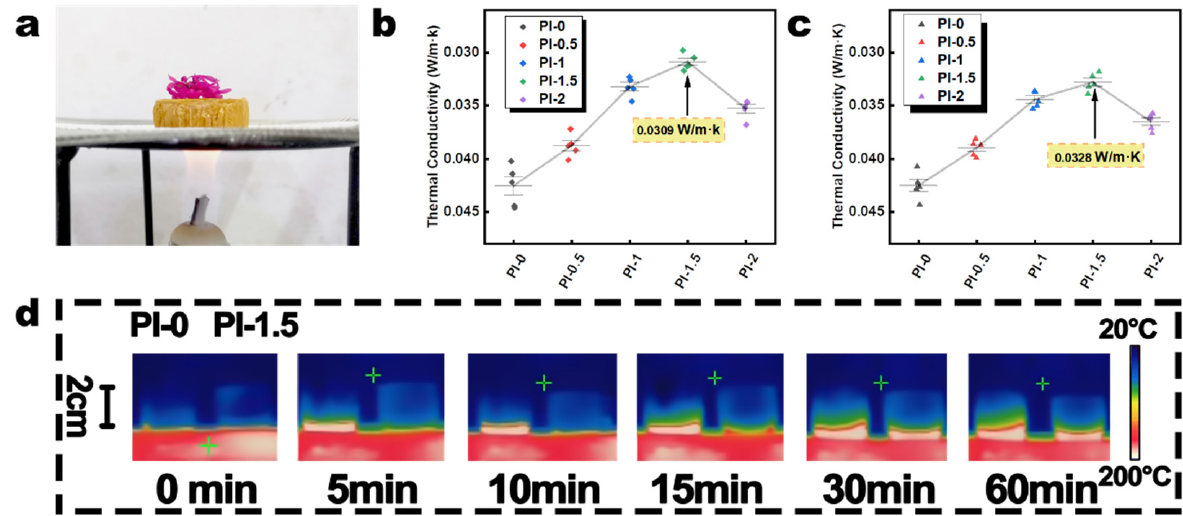
decrease, indicating that the excess SiO 2 @GO-NH 2 for the disruption of the microstructure Figure 6. ( a ) PI-1.5 and flowers on the flame of the alcohol burner for 15 min. ( b,c ) Thermal conduc- of the PI aerogel instead reduced the thermal stability of the aerogel [64].